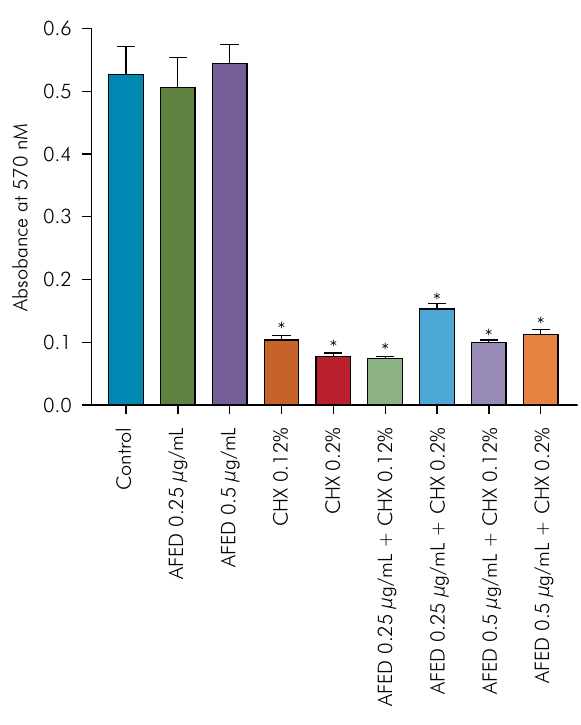
Figure 1. Effect of acetone fraction of Eugenia dysenterica (AFED) on cell viability of gingival fibroblast cells (GFC) under chlorhexidine (CHX) treatment. The MTT assay was performed to measure cell viability of GFC after treatment with AFED 0.25 μ g/mL and with AFED 0.5 μ g/mL; CHX 0.12%; CHX 0.2%; AFED 0.25 μ g/mL + CHX 0.12% or AFED 0.25 μ g/mL + CHX 0.2%; AFED 0.5 μ g/mL + CHX 0.12% or AFED 0.5 μ g/mL + CHX 0.2%. Controls were maintained in regular medium. The statistical analysis (one-way ANOVA with Tukey’s test) compares treatment with control (*p <